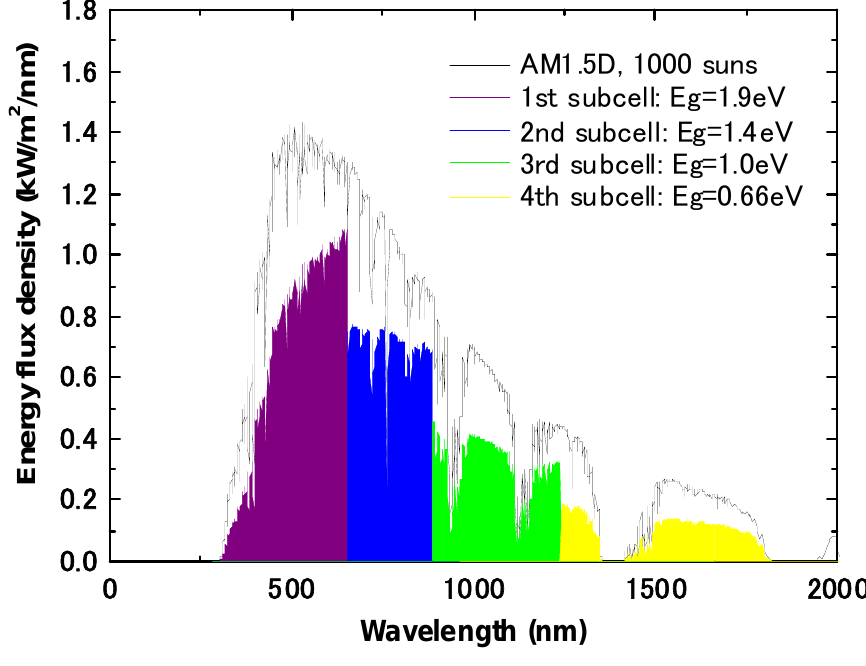
Figure 10. Solar irradiation spectrum of AM1.5D, 1,000 suns and energy utilization spectrum by a series-connected AlInGaP (1.9 eV) / GaAs (1.4 eV) / 1.0 eV / Ge (0.66 eV) four-junction solar cell calculated with the “detailed balance limit” scheme with current- match restriction. Calculated energy conversion efficiency η = 60.9% ( η = 47.7% under AM1.5G, 1